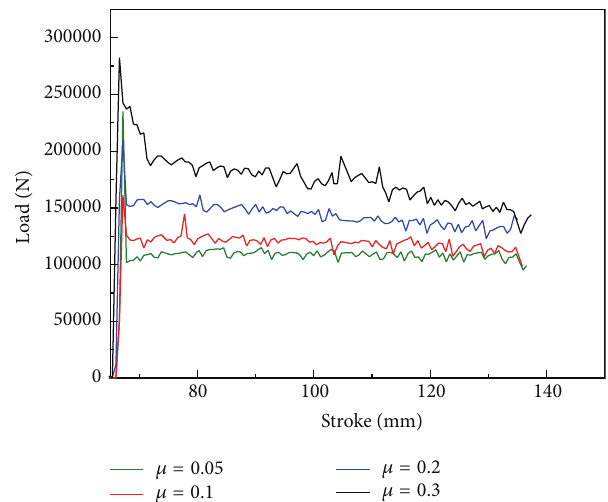
Figure 6: The load of the die with different friction